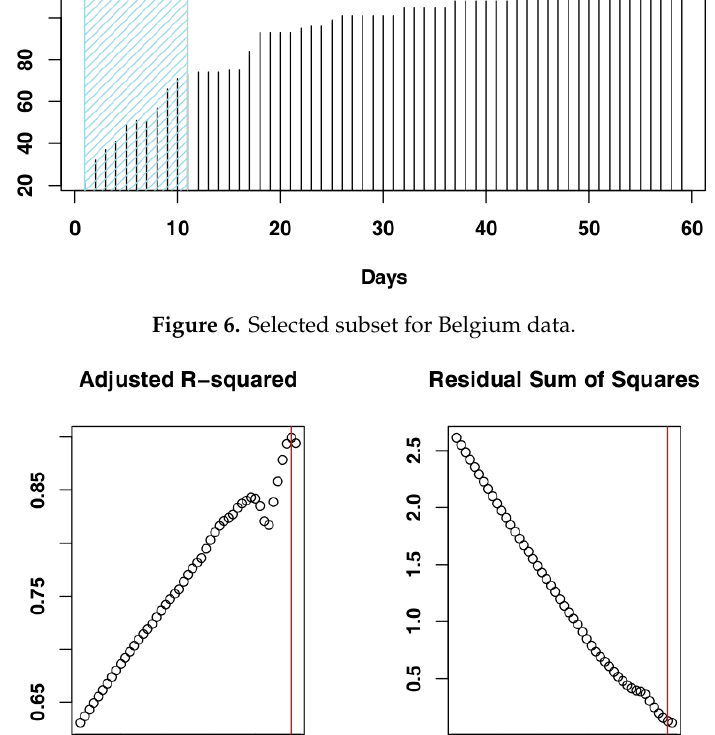
Figure 8. Model fitting for the selected subset for Belgium data. 3.2. Doubling Time and R 0 Estimation The doubling time for the selected subset resulted to be 4.39 days for Czech Republic and 6.43 days for Belgium (Table 1). When we resolve Equation (1) for D = 6, the resulting R 0 is 1.95 for Czech Republic and 1.65 days for Belgium (Table 1). Table 1. Exponential equations, doubling time values, and R 0 values for Czech Republic and Belgium epidemics.